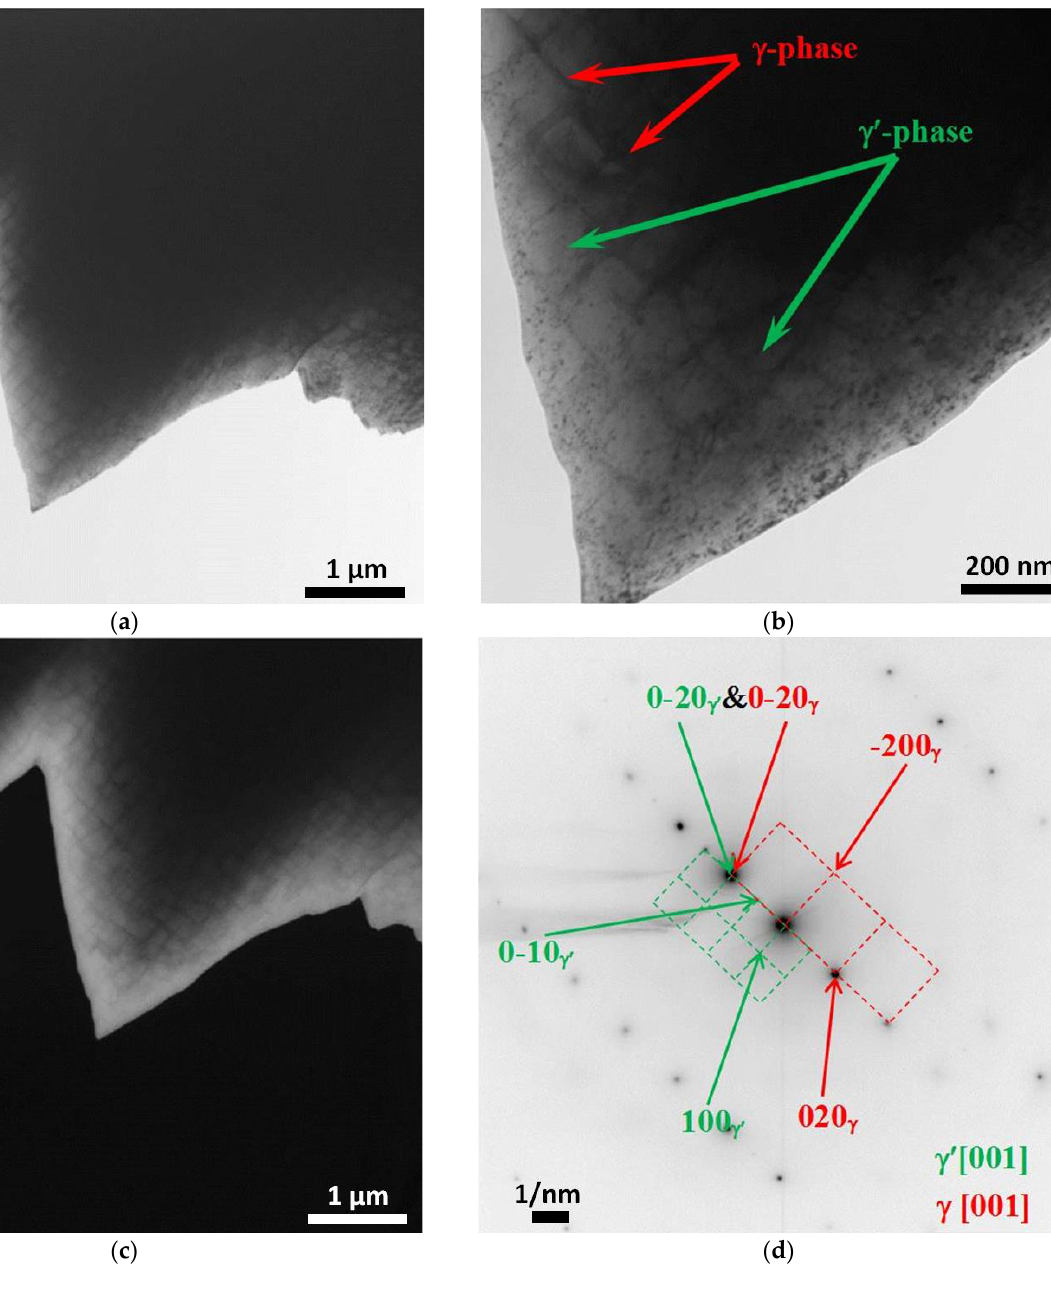
Figure 8. Fine structure of material of products obtained by wire-feed electron beam additive manufacturing at a distance from the substrate of 31 mm. Bright-field ( a , b ) and dark-field ( c ) TEM images, SAED and its identification scheme ( d ). Dark-field image taken in the reflection 0 – 10 γ’ .